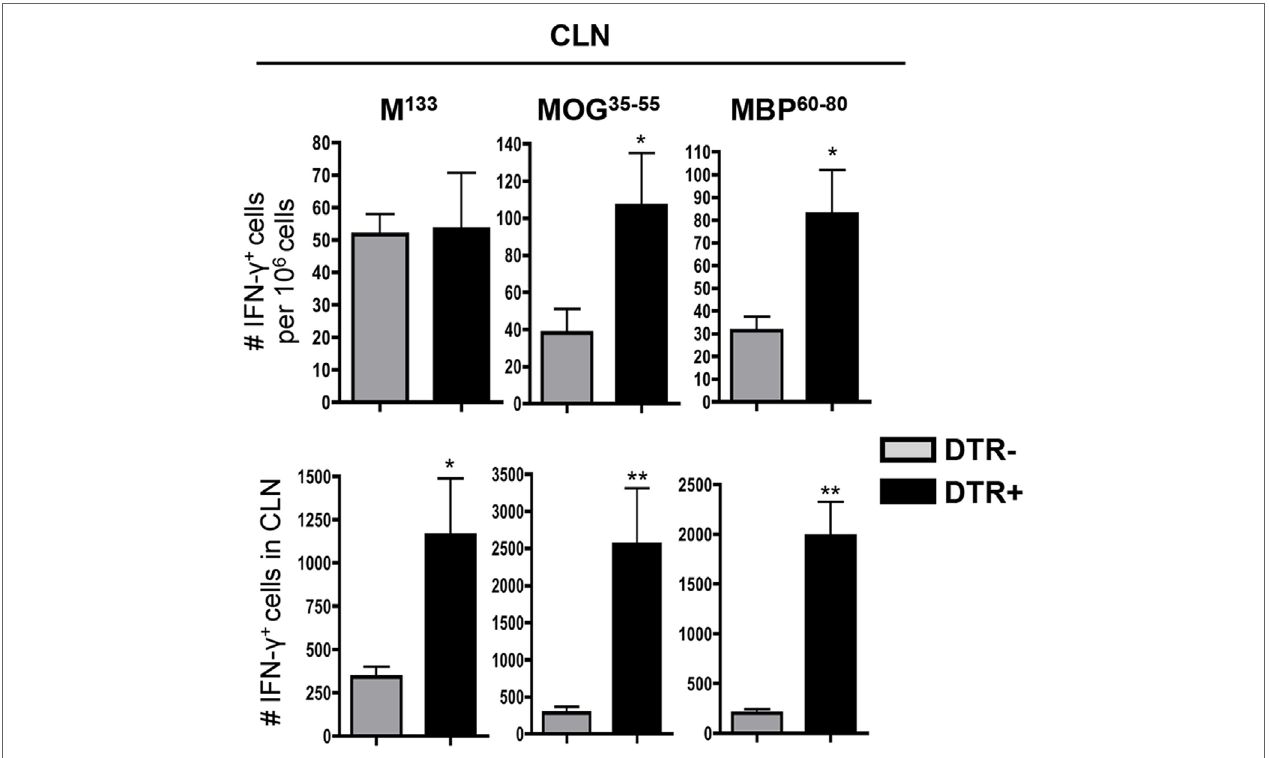
FigUre 3 | Foxp3 + Tregs control peripheral sr cD4 + T cell response during chronic JhMV infection . Frequencies and absolute numbers of virus-specific M 133 , myelin-specific MOG 35 − 55 , and MBP 60 − 80 CD4 + T cells in CLN of JHMV-infected DTR − and DTR + mice treated with DT between d21 and d28 p.i. determined by ELISPOT. The Number of spots detected in wells without stimulation was subtracted to exclude non-specific CD4 + T cells. Data represent the mean of two separate experiments with seven to eight pooled mice per group per experiment. * p < 0.05, * p < 0.01, Mann–Whitney